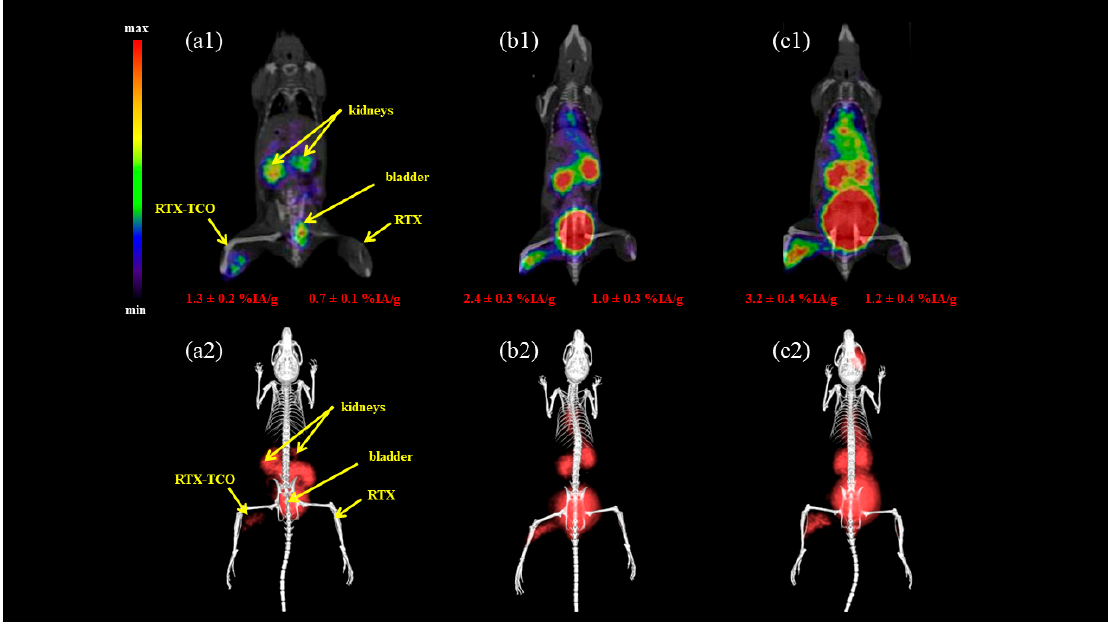
Figure 4. Static µPET/CT image of i.m. RTX(-TCO) pre-treated normal BALB/c mice 5 h after treatment and 90 min p.i. of the 68 Ga-labelled Tz-monomer ( a ), Tz-dimer ( b ) and Tz-trimer ( c ). (1 = coronal slice; 2 = 3D volume rendered projections; both prone position).